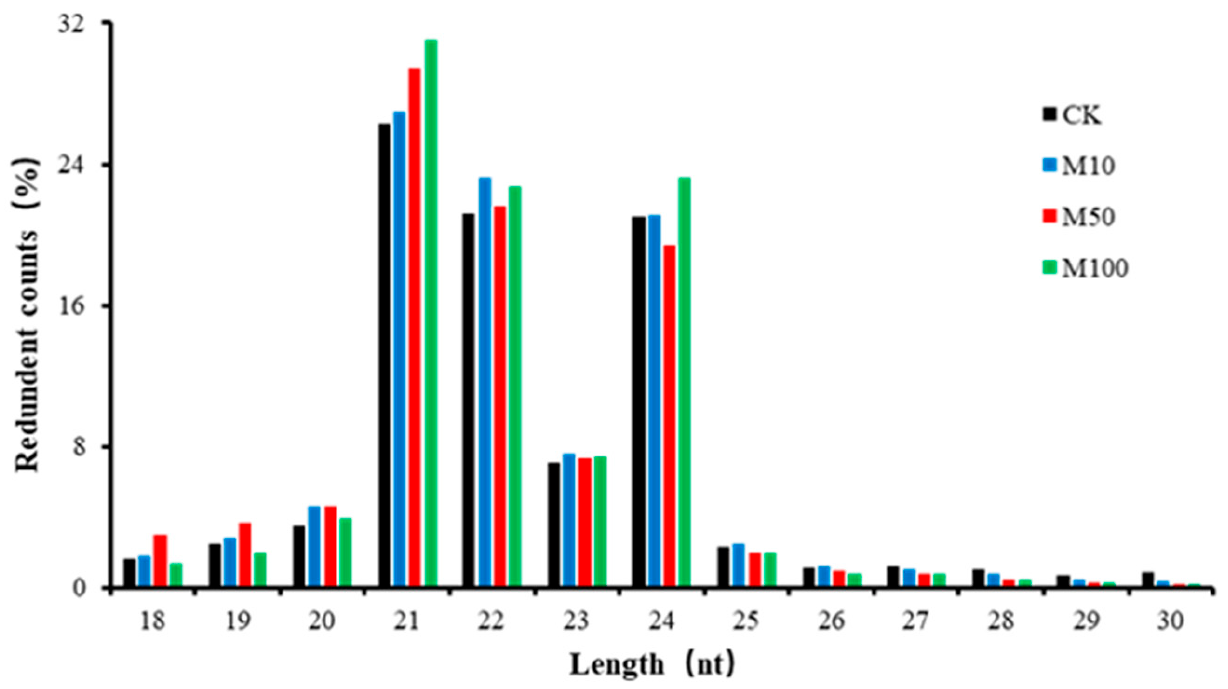
Figure 2. Length distribution of small RNA sequences in the small RNA libraries. Four sRNA librar- ies 0 (CK), 10 (M10), 50 (M50), and 100 μ M MeJA (M100).